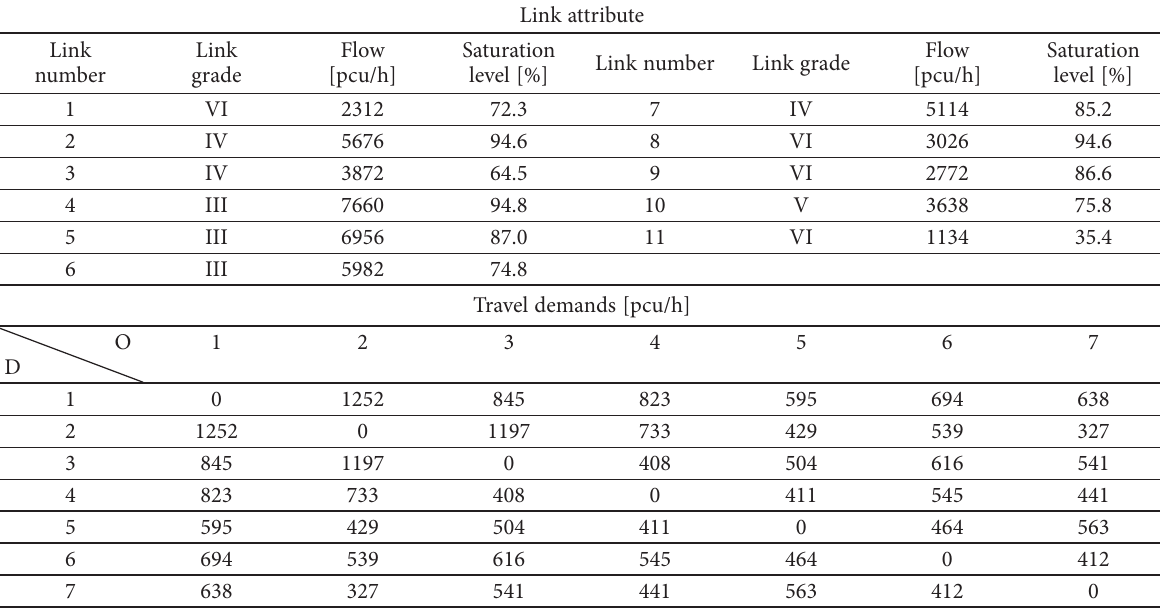
Table 3. Link attributes and travel demand in reformed